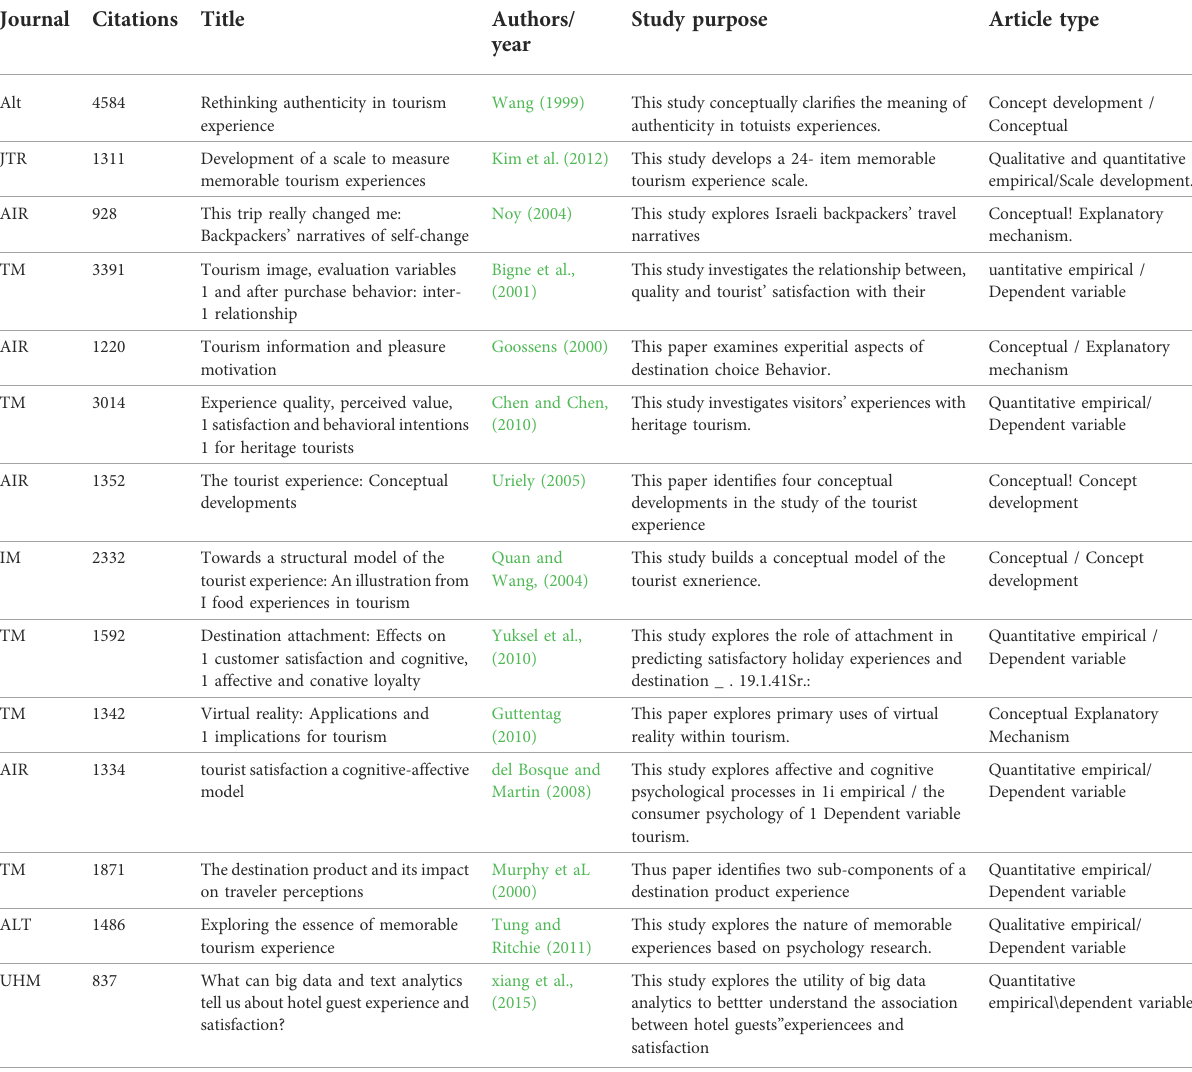
TABLE 1 Top 14 most cited articles of all time in hospitality and tourism journals by June